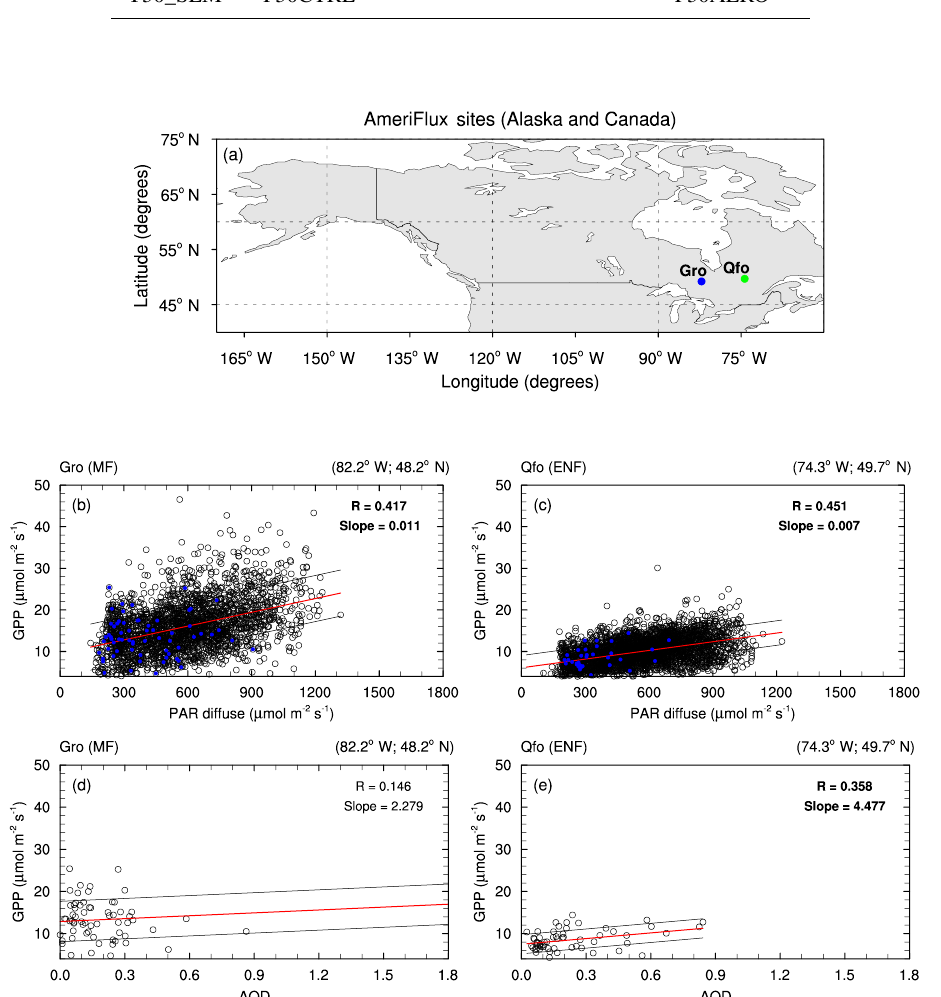
Figure 2. Relationships between (b, c) GPP and diffuse PAR and (d, e) GPP and MODIS AOD at (a) two boreal sites: Groundhog River (Gro) and Québec Mature Boreal Forest Site (Qfo). The two sites are from the AmeriFlux network in Canada and are dominated by mixed forest (MF at Gro) and evergreen needleleaf forest (ENF at Qfo) (Table 1). Data cover summer days (June–August). AmeriFlux diffuse PAR and GPP (in µmolm − 2 s − 1 ) are half-hourly observations (10:00–14:00LT). Instantaneous MODIS Aqua and Terra 3km AOD are selected in a time span centered on AmeriFlux record time. For each plot: the red line indicates the regression line and black lines depict the 1 σ interval; the regression slope and correlation coefficient are both included for each site (in bold if statistically significant at 95% confidence level). Blue dots in panels (b, c) show instants when MODIS Aqua and Terra 3km AODs overlap AmeriFlux